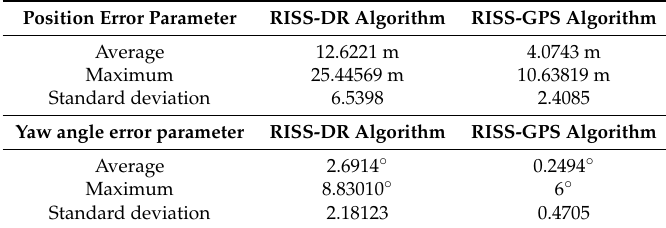
Figure 11. Position and yaw error diagram. ( a ) RISS-GPS and RISS-DR position error diagram; ( b ) RISS-GPS and RISS-DR yaw error diagram. Table 1. The error parameter of the navigation system.